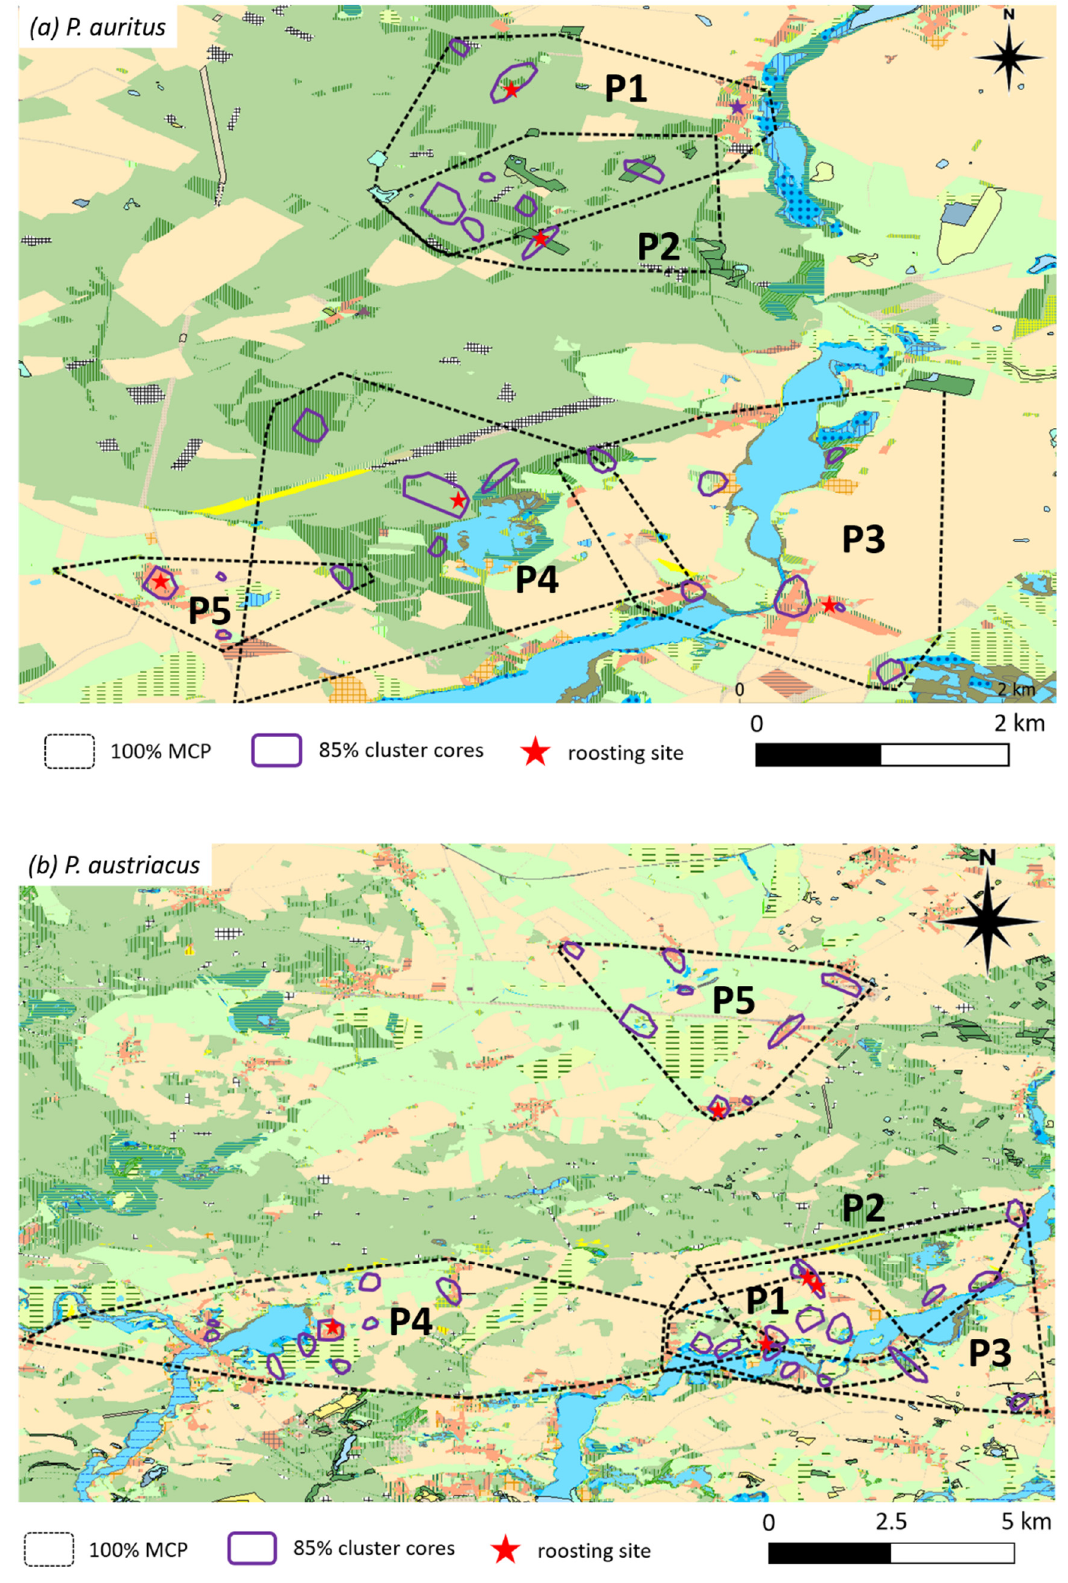
Figure 4. MCPs and 85% cluster core areas of female P. auritus ( a ) and P. austriacus ( b ) radio-tracked during maternity seasons between 2013 and 2015 ( a and b respectively; n = 5 females).